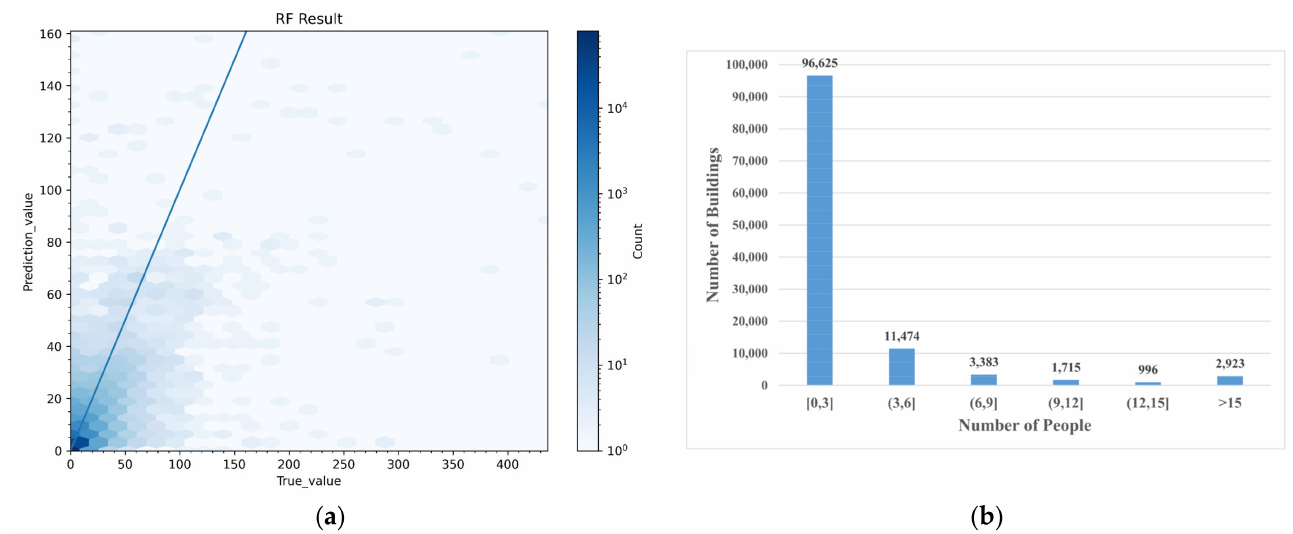
Figure 6. ( a ) Hexagonal bin plot and ( b ) histogram of the RF model results.